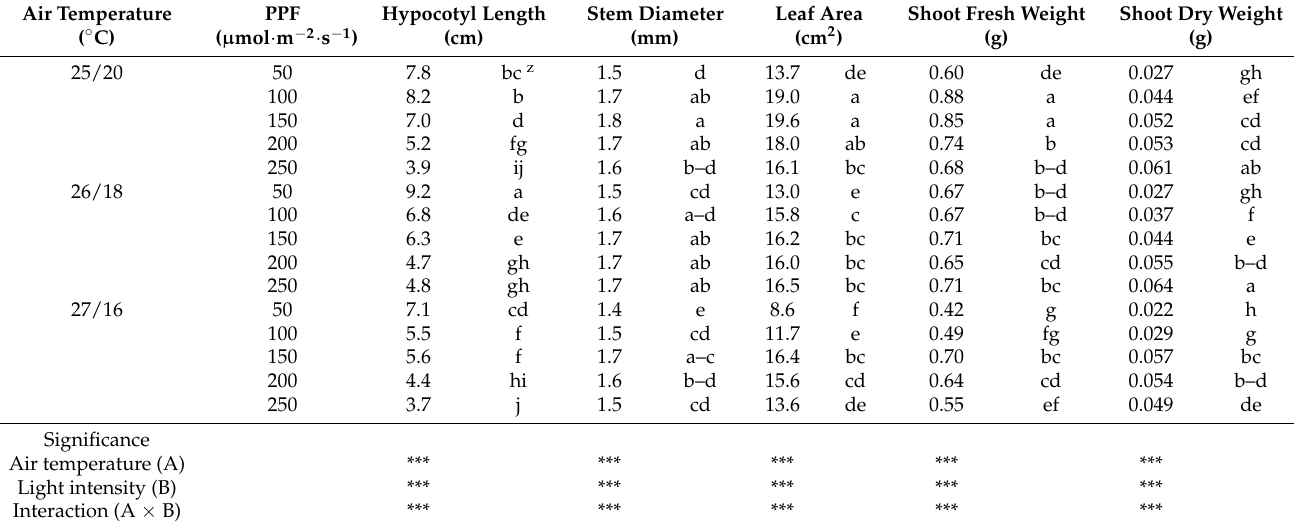
Table 1. Growth of cucumber scions as affected by the different air temperature and light intensity at 6 days after cultivation in a